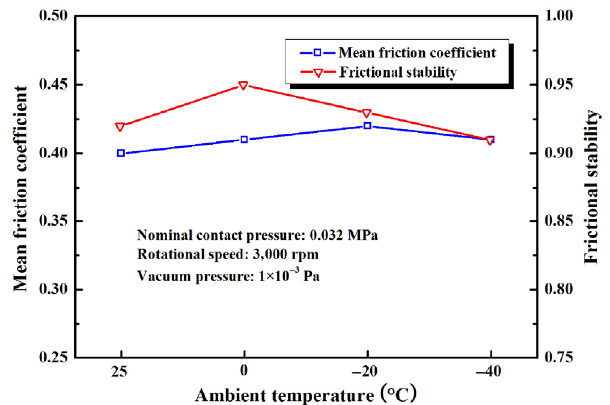
Fig. 7 Variations of μ mean and FS with ambient temperature.